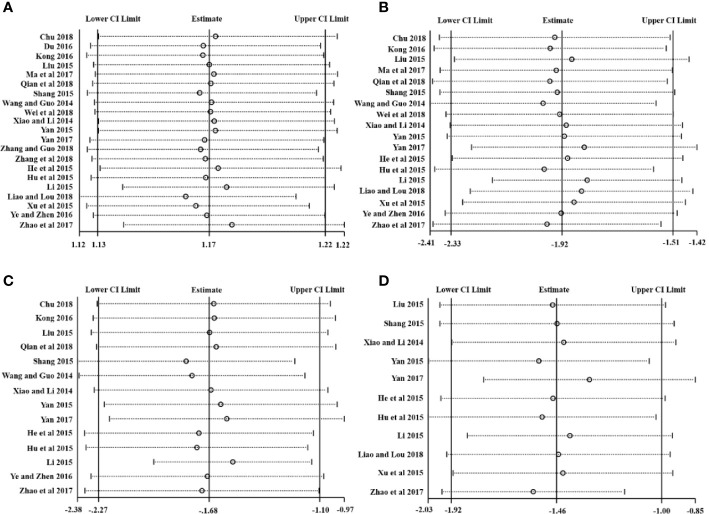
Sensitivity analysis plots of (A) CER, (B) RTC, (C) RTR, and (D) RTF.